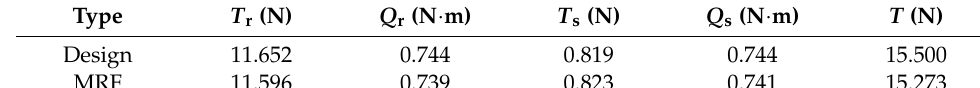
Table 5. Performance comparison of the 150 ducted fan in the incoming flow state.